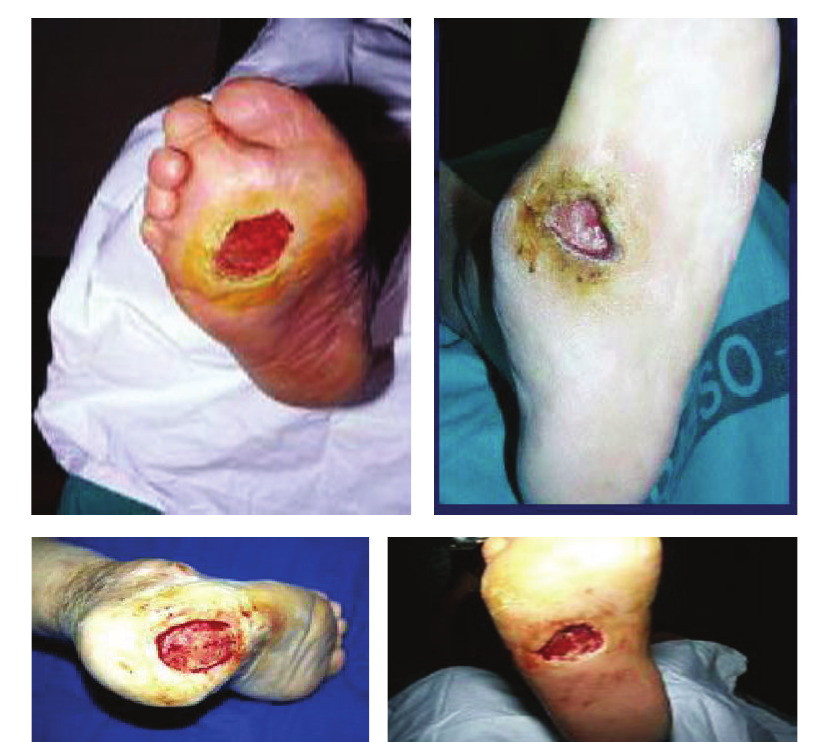
Figure 2: Neuropathic